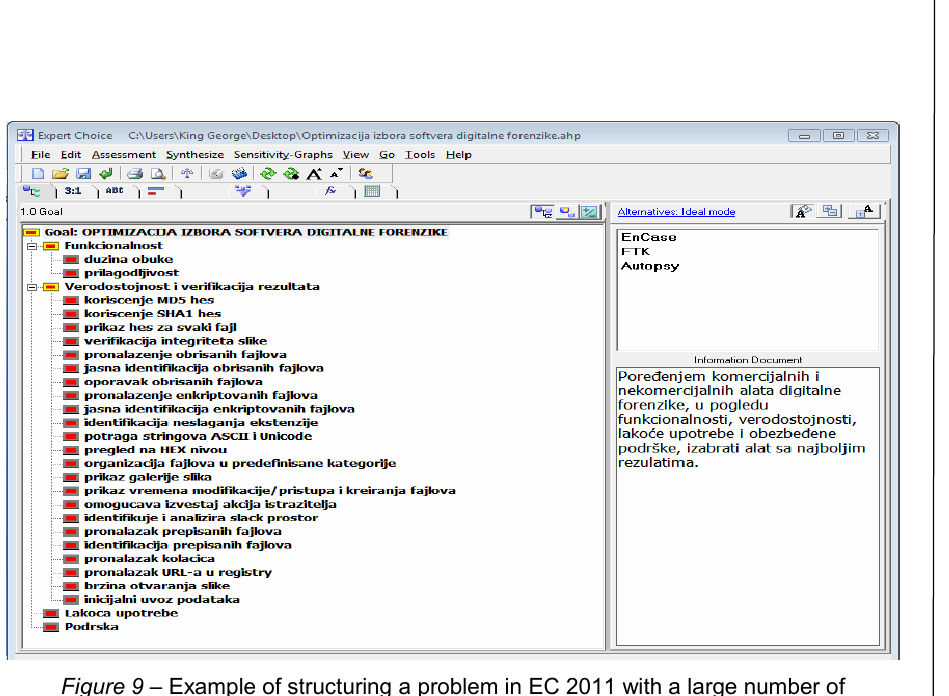
Figure 9 – Example of structuring a problem in EC 2011 with a large number of alternatives, criteria and sub-criteria Рис . 9 – Пример структурирования проблемы в программе ЕС 2011 при